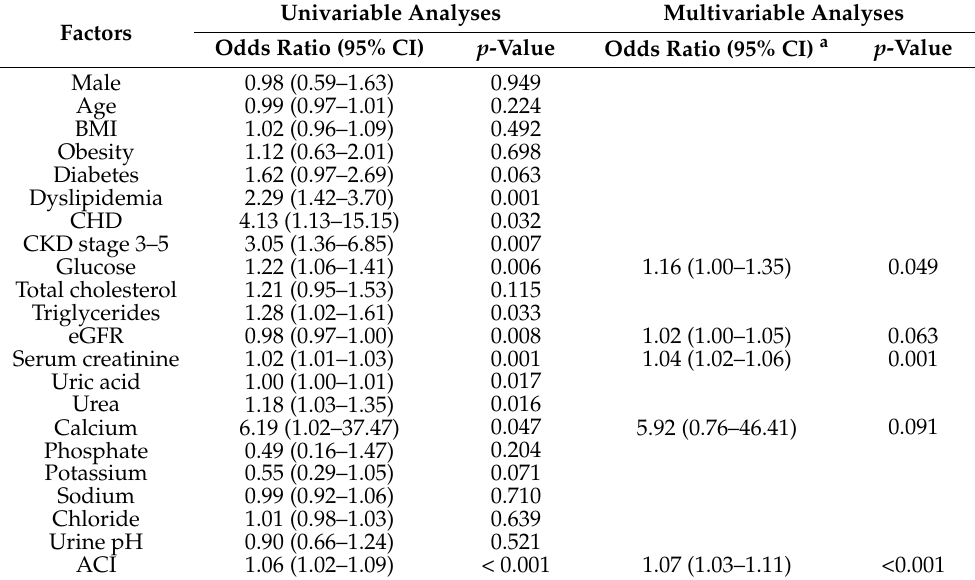
Table 2. Univariable and multivariable analyses of the risk factors of urinary stones. Univariable Analyses Multivariable Factors